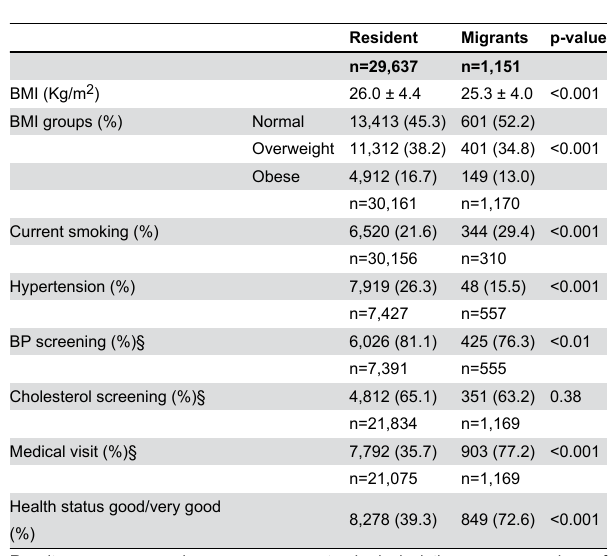
Table 1. Characteristics of the samples according to immigration status.